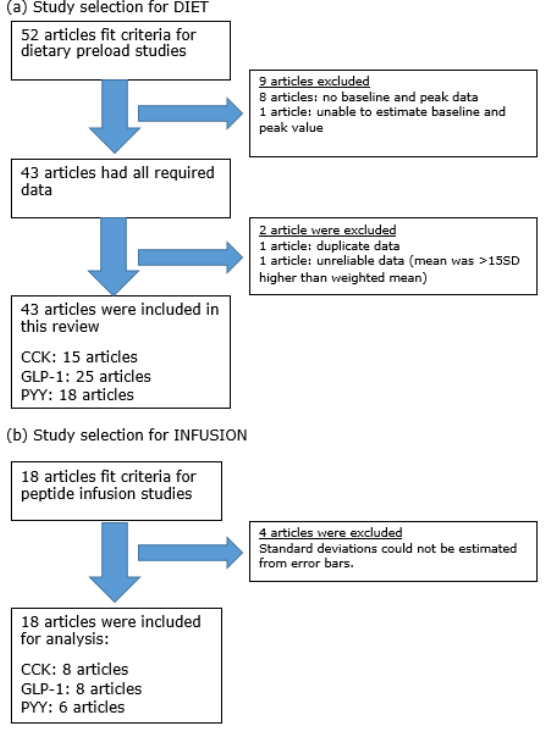
Figure 2. Flow diagram of article selection for ( a ) DIET and ( b ) INFUSION studies. Some articles reported >1 GI-peptide.